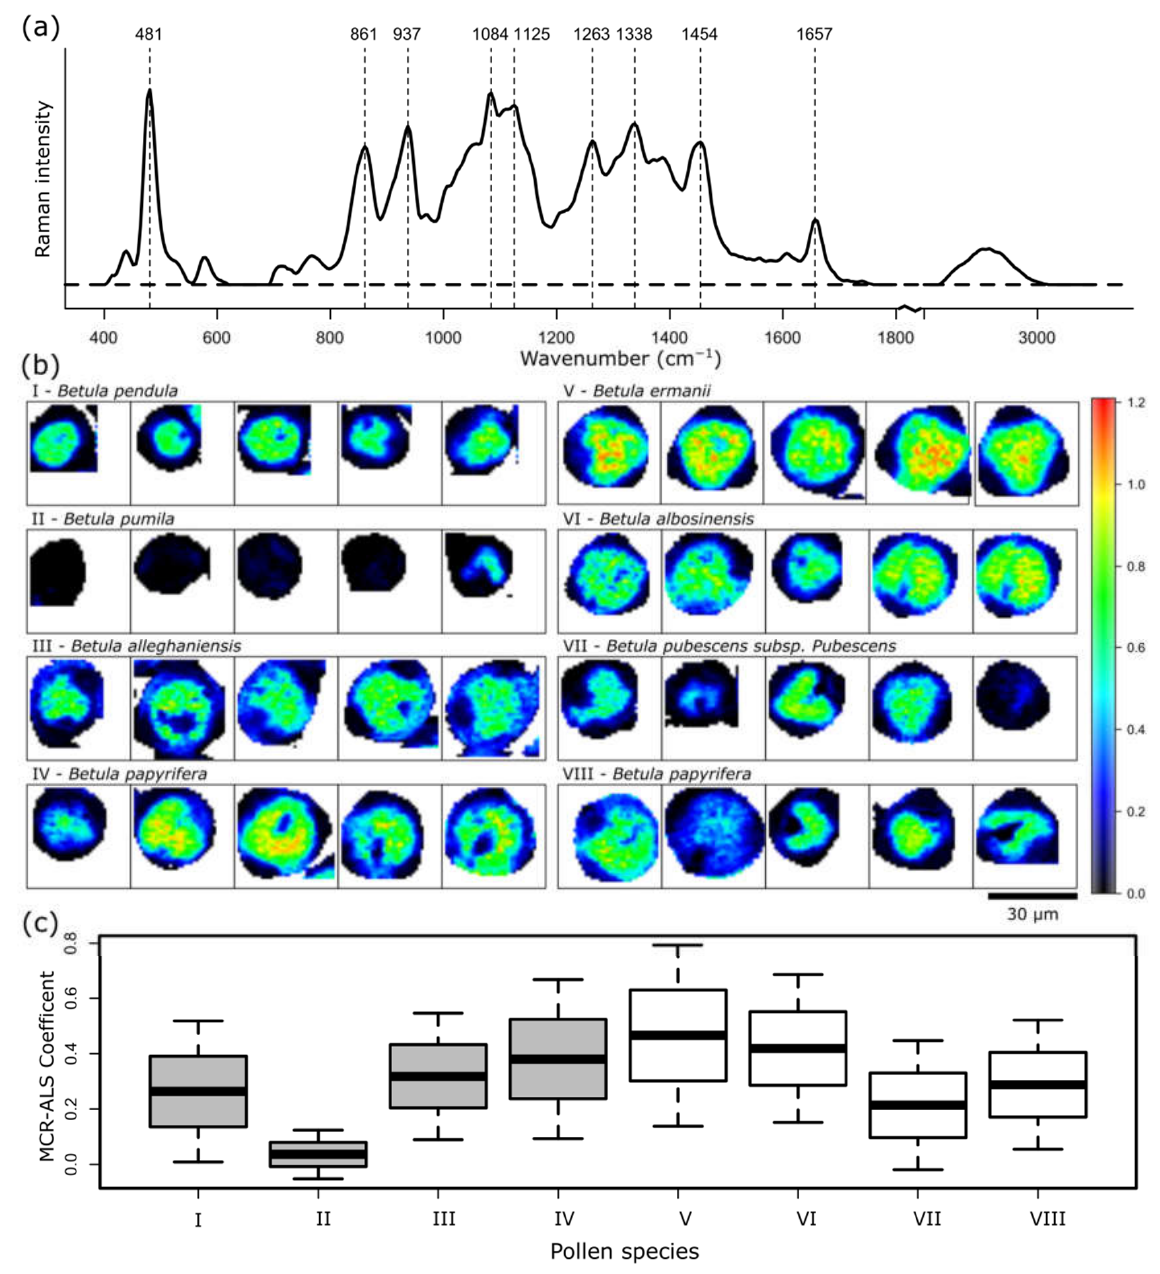
Figure 5. MCR-ALS results for the component representing carbohydrates. ( a ) Calculated spectrum, ( b ) spatial distribution, and ( c ) mean concentration of the components of seven different pollen species. Pollens ( I – IV ) were collected in the Botanic Garden Jena of the Friedrich Schiller